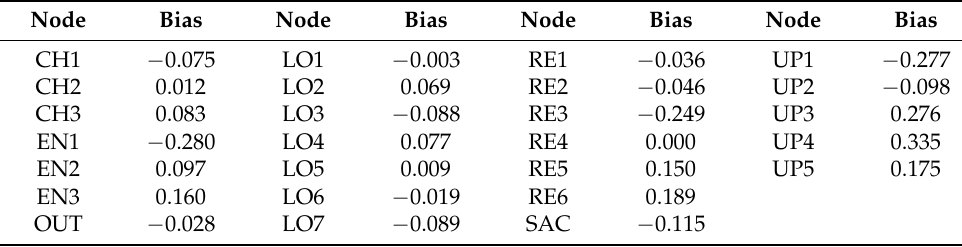
Table 1. Temperature bias ( ◦ C) for each node, derived from the calibration